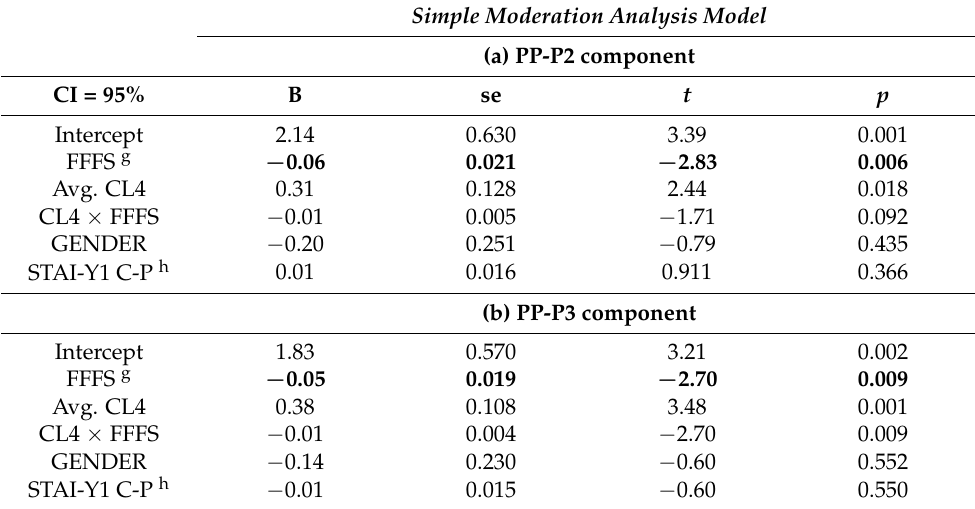
Table 3. Multiple regression of cluster 4, CL4 (C4, T4 EEG sites) on FFFS RST-PQ trait. Simple Moderation Analysis Model